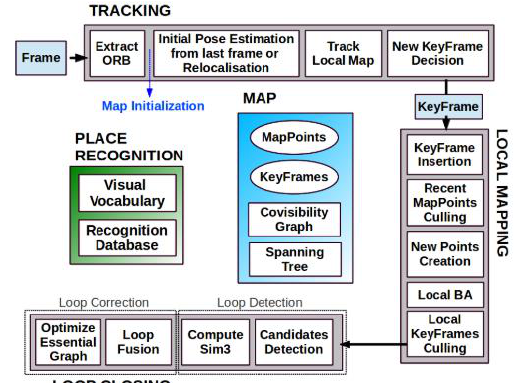
Figure 3. ORB-SLAM system overview, showing all the steps performed by the tracking, local mapping, and loop closing threads. (Ra´ul Mur-Artal et al.,2015)